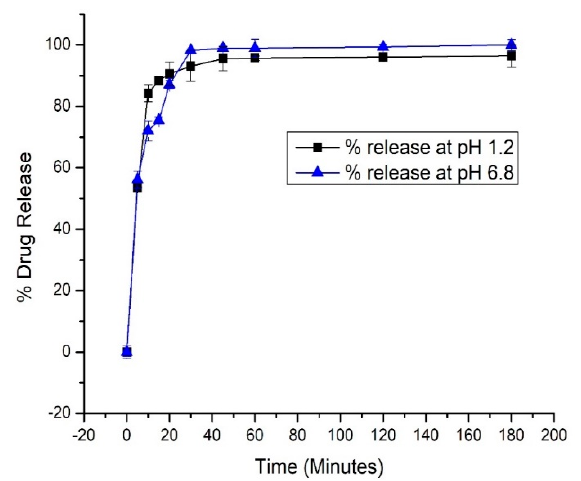
Figure 8. Release profiles of VLP-MSN in buffer (pH 1.2, 6.8). Error bars indicate the standard deviation ( n = 3).